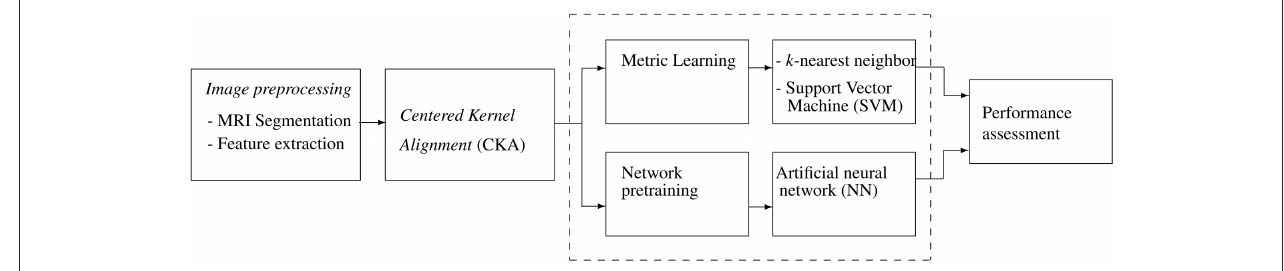
FIGURE 1 | Schematic training pipeline: Input MRI is automatically segmented and a set of features are further extracted. CKA learns a metric or pre-trains network weigths. Tuned classifiers ( k -nn, SVM, and ANN) are used for computer-aided diagnosis task.